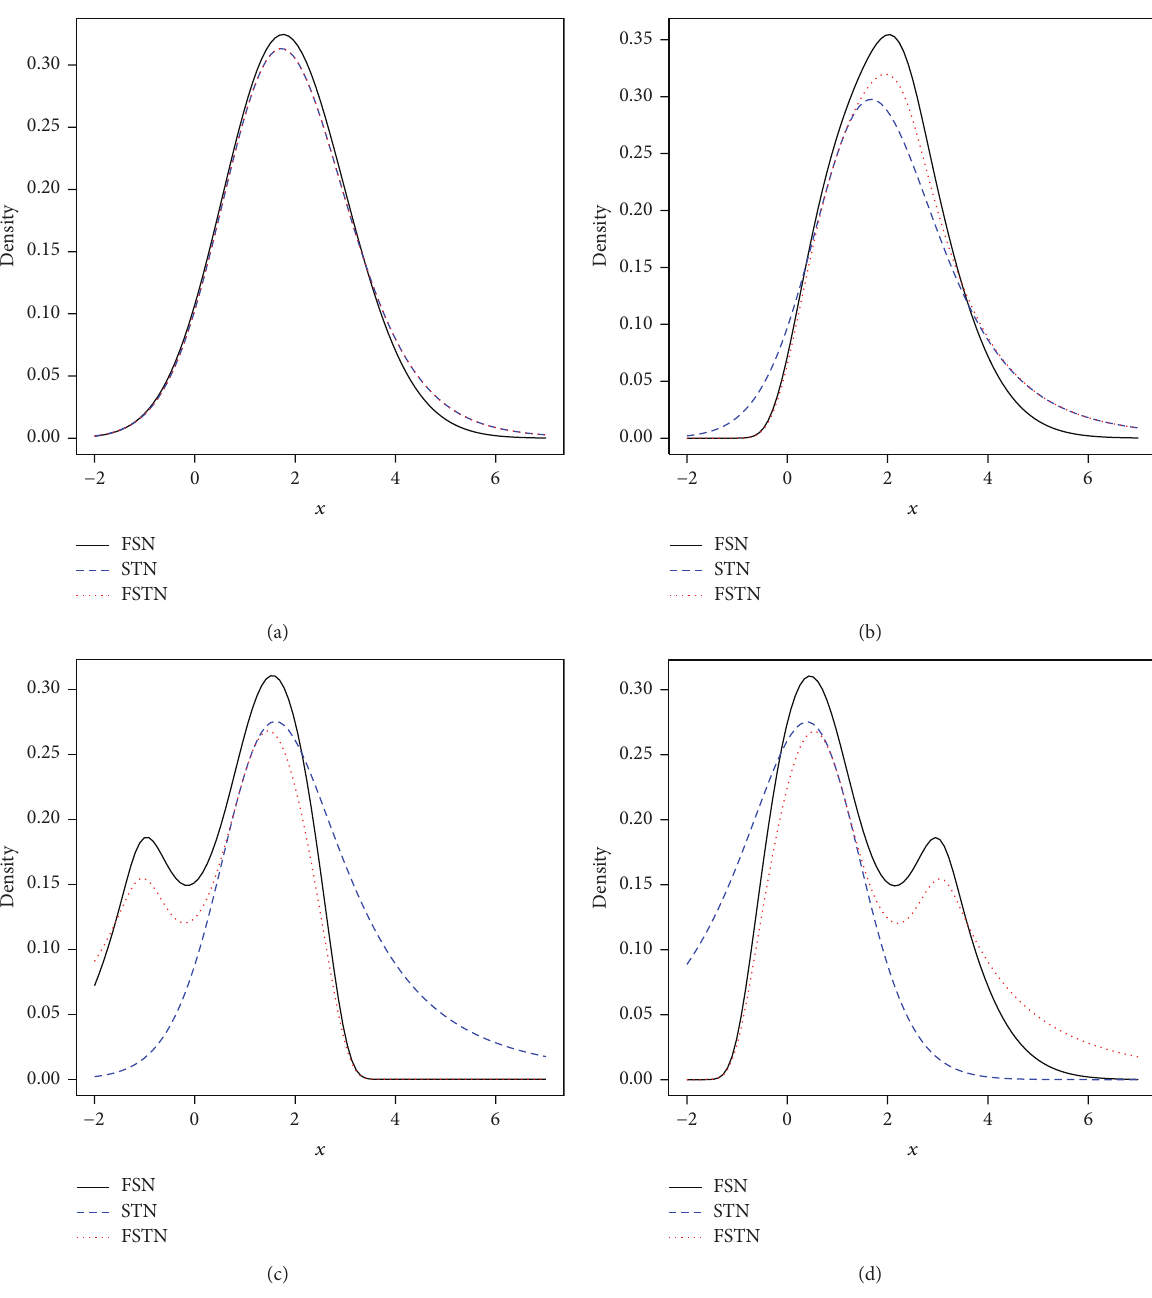
Figure 1: ((a)–(d)) Density functions of FSN, STN, and FSTN distributions with four different